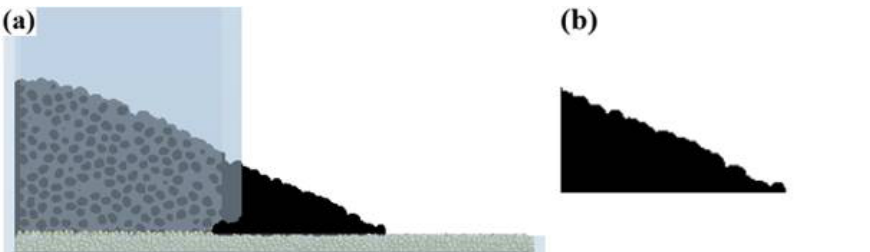
Figure 4. ( a ) Graph of simulation results of piling test, and ( b ) angle of repose of soybean seed particles in contact with soil particle.